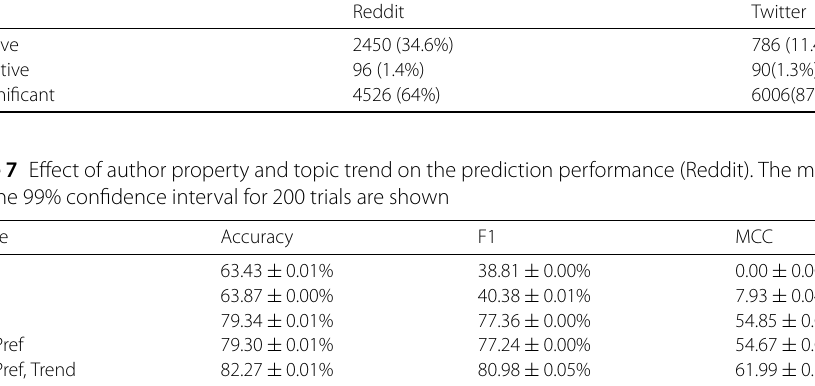
Table 6 Distribution of the susceptibility α i to the community feedback (up/down-votes and likes) Group